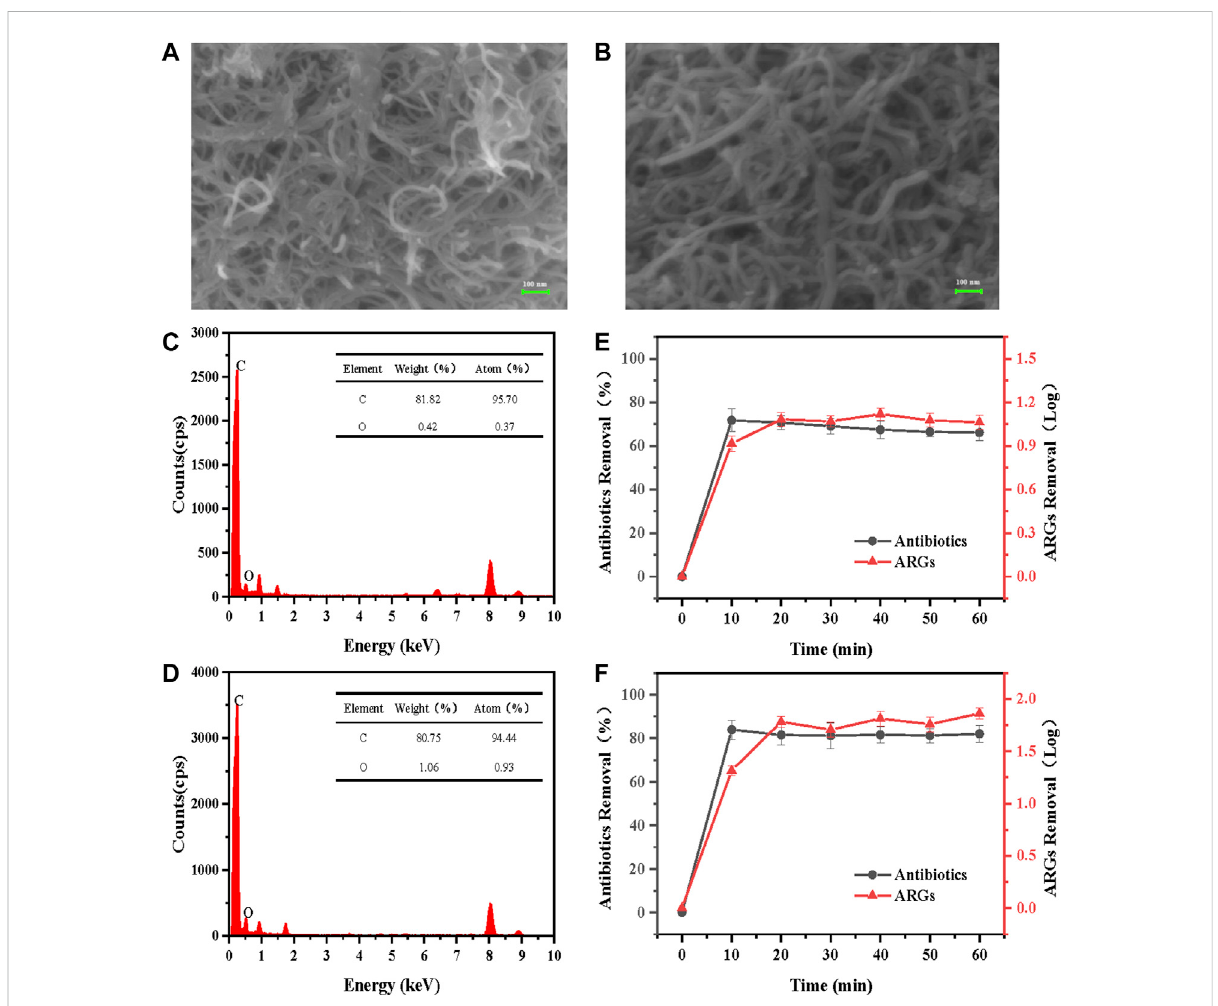
Supplementary Table S2. Determination of intermediate products of antibiotics degradation by high performance liquid chromatography tandem quadrupole time-of- fl ight mass spectrometry (Q-ToF-MS). Mass spectrometry was performed using an electrospray ionization source in positive ion mode (ESI+) and multiple reaction